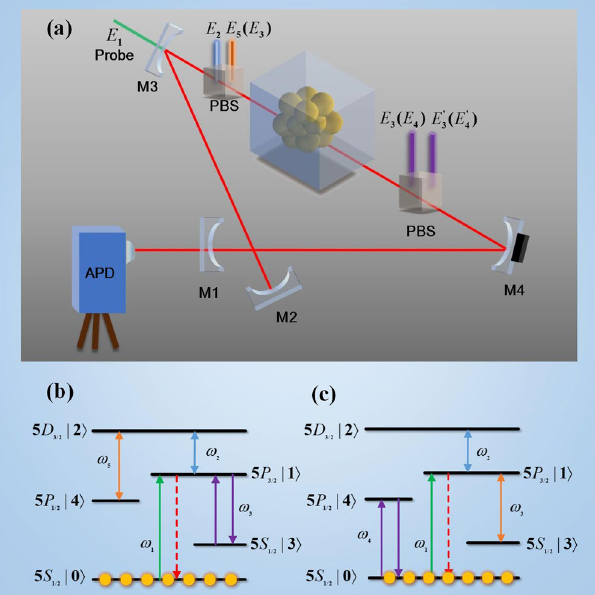
Figure 1. ( a ) Diagrammatic setup of FWM signal generation, consisting of four reflectors to form the ring cavity, and embedded nonlinear media 85 Rb to produce the signal. The cavity frequency can be modulated by the piezoelectric transducer (PZT) that is mounted on mirror M4. An avalanche photodiode (APD) is placed at the terminal of the setup to detect the signal. PBS is the piezoelectric beam splitter. ( b ) The nested type interaction mode coupled with five energy levels. ( c ) The cascade type interaction mode coupled with five energy